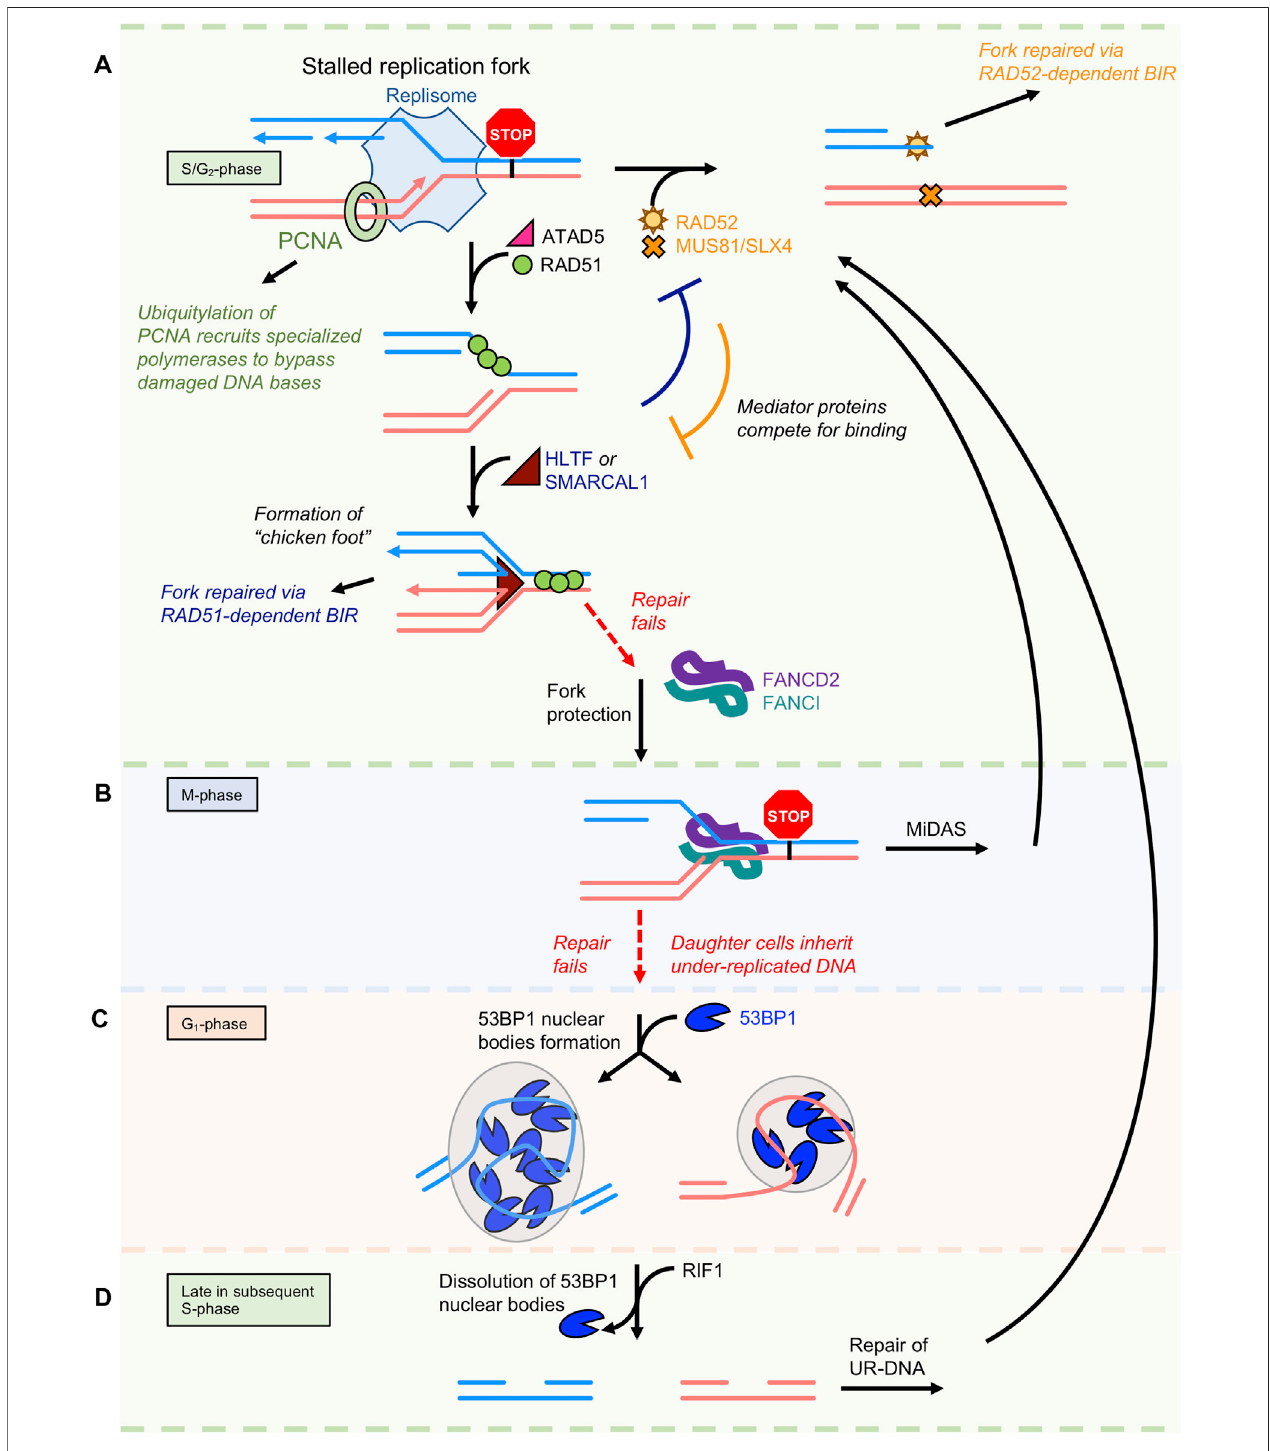
FIGURE 2 | Repair of stalled replication forks via BIR. (A) Multiple DNA repair pathways compete to repair stalled replication forks during S/G 2 phase of the cell cycle. (B) Once the cell enters M-phase, unrepaired forks become bound by the FANCD2/FANCI complex. It will attempt to repair the lesion again by a RAD52- dependent BIR-like pathway termed mitotic DNA synthesis (MiDAS). (C) If still unsuccessful, the cell with complete mitosis with each daughter cell inheriting under- replicatedssDNAthatisprotectedbythe53BP1proteinduringG 1 . (D) InthesubsequentS-phase,thecellhasone fi nalattempttorepairunder-replicatedDNA via BIR. After this point, the cells must undergo apoptosis or pass on an incomplete genome.